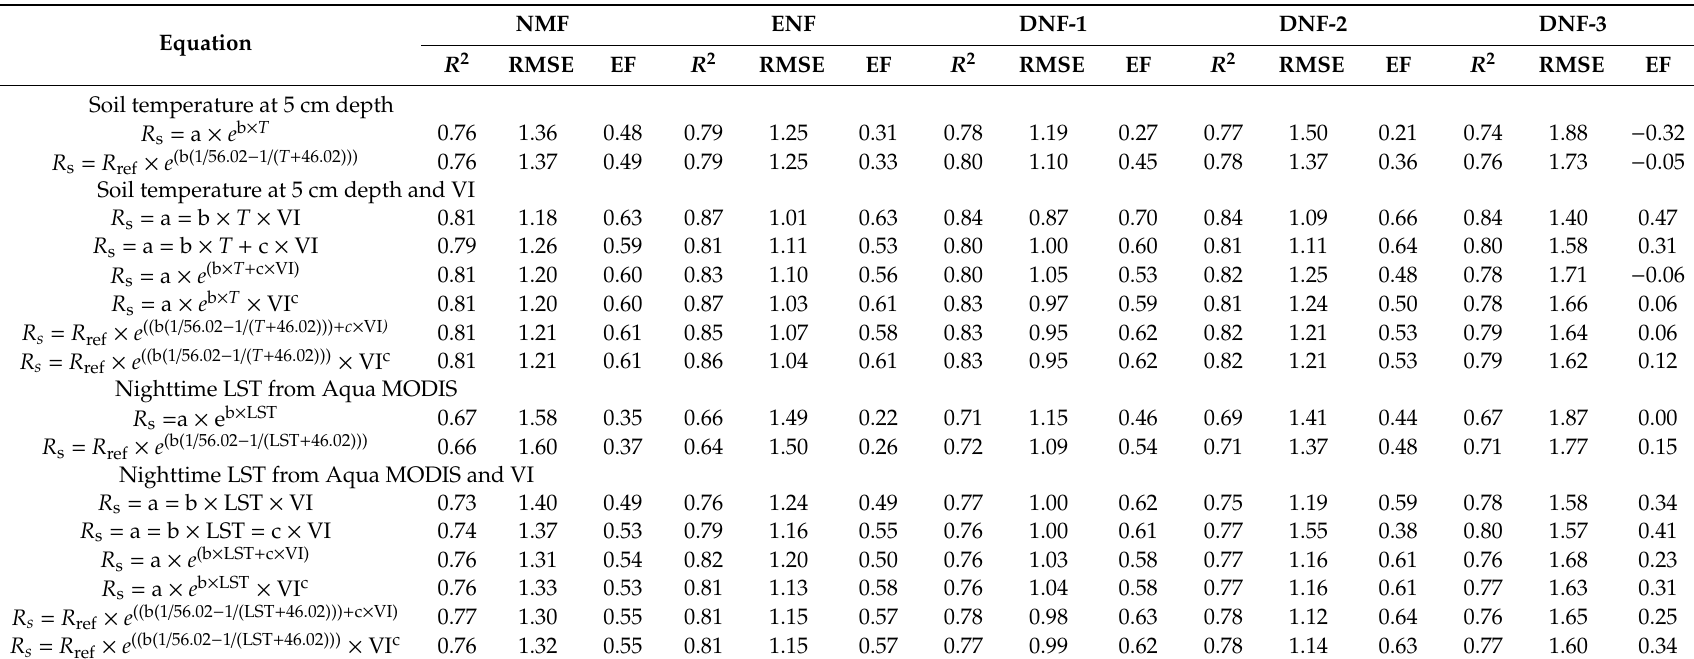
Table 8. The leave one out cross-validation statistics for the respiration models of the five sites during the measurement. NMF ENF DNF-1 DNF-2 DNF-3 Equation R 2